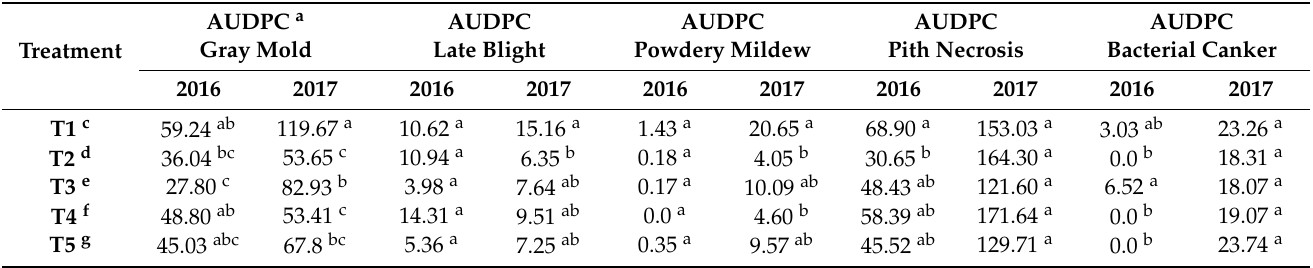
Table 1. Effect of soil-application of Bacillus spp. and foliar application of different biorational products in the control of major tomato diseases in greenhouse in Mexico in 2016 and